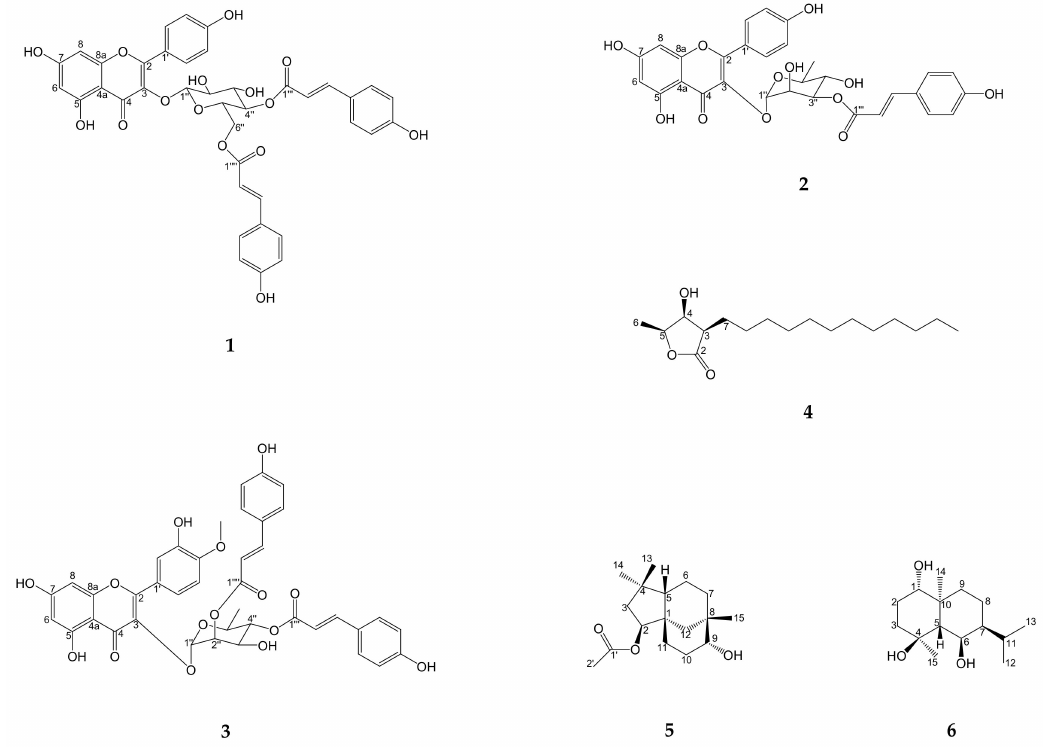
Figure 1. Compounds 1 – 6 isolated from the aerial part of L.